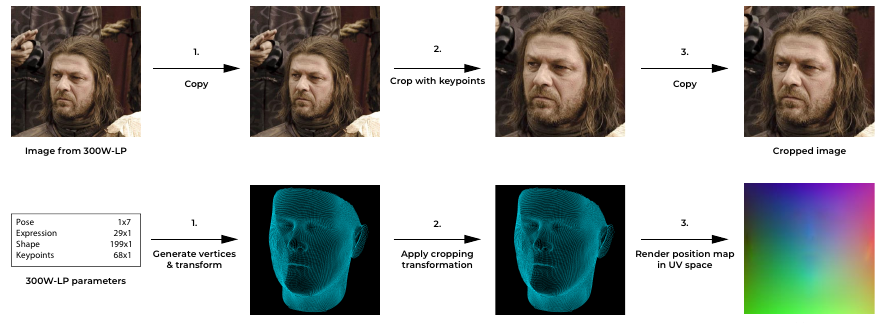
Figure 4. The 300W-LP training data generation pipeline. The pipeline in the top row corresponds to a pre-processing procedure and is related to the 2D data. In the pre-processing, the image is cropped based on the provided key-points and the crop parameters were kept. The pipeline in the second row represents the actual generation of the 3D training data. First, the vertices are generated and transformed to the correct pose using the face3d library. Then, the vertices are cropped according to the crop parameters that were previously extracted. Finally, the position is rendered map in UV